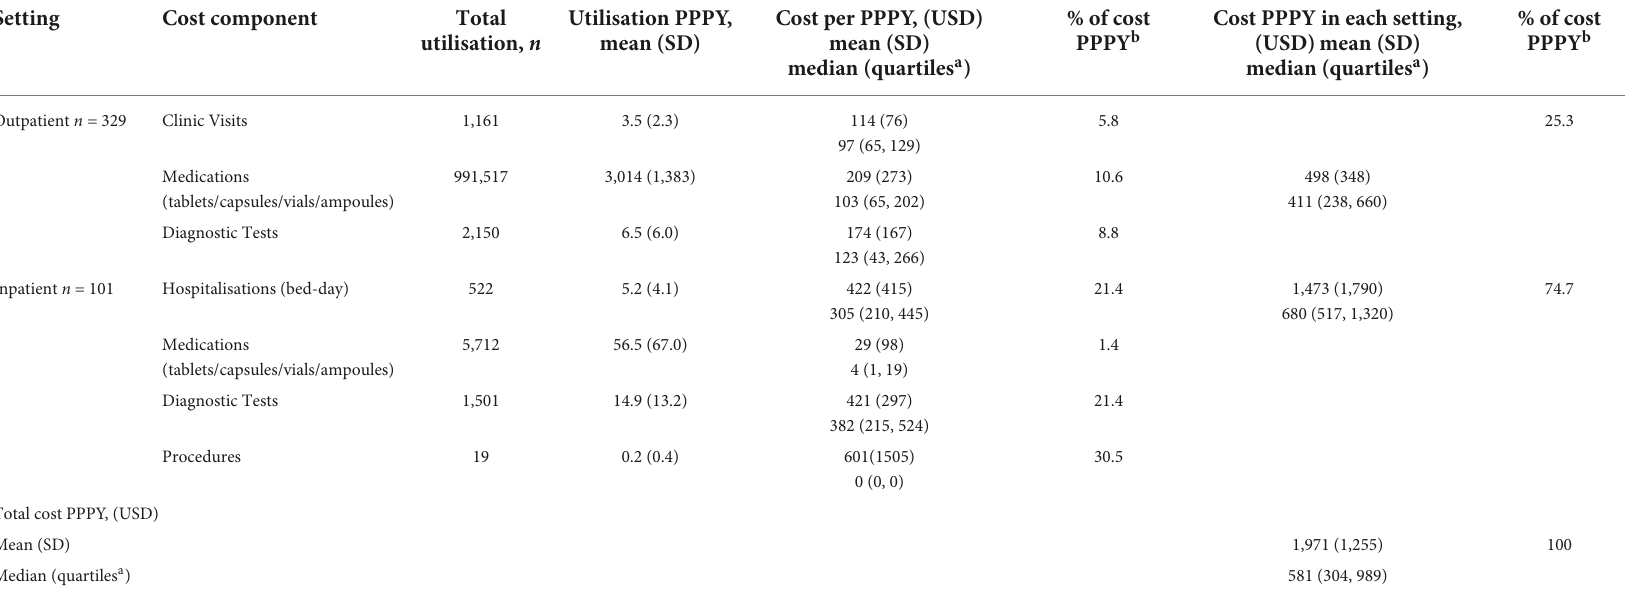
TABLE 2 Health care resource utilisation and cost distribution of heart failure patients.